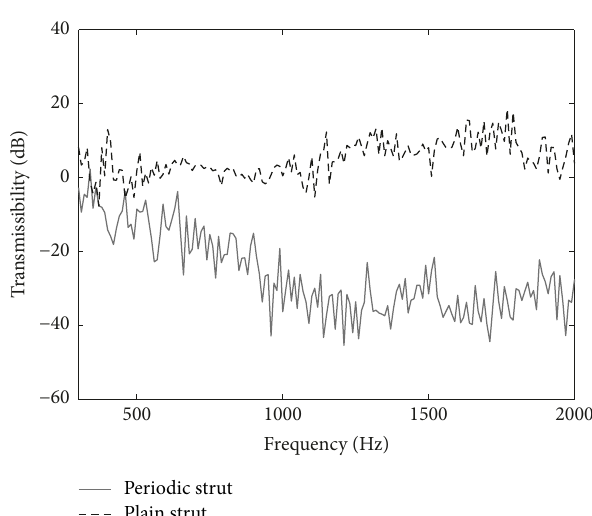
Figure 12: Experimental transmissibility of gearbox